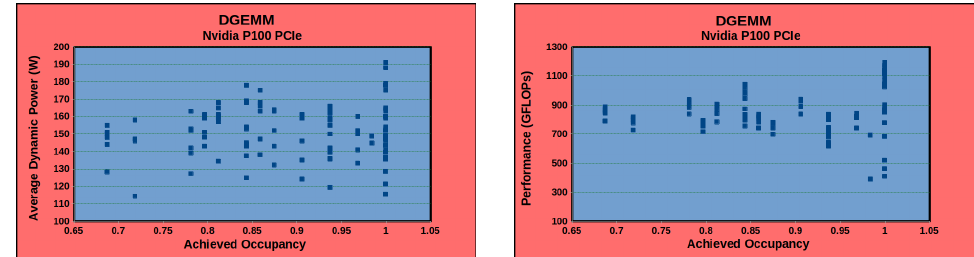
Figure 11. Average dynamic power versus achieved_occupancy and performance versus achieved_occupancy for the matrix multiplication application employing the CUBLAS DGEMM routine on Nvidia P100 PCIe GPU (Figure 1).